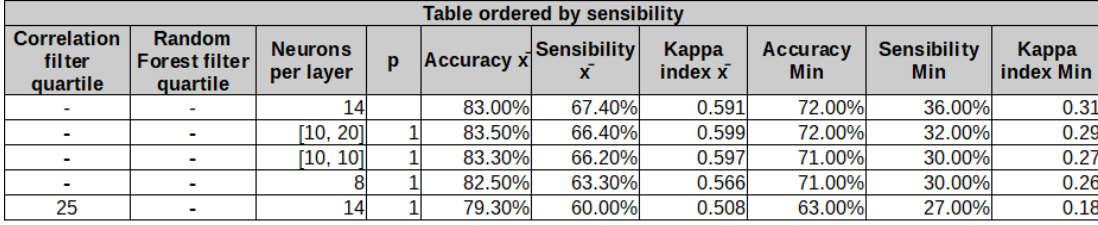
Figure 1. Statistics of the best models applied in the Vigo. A production area, ordered by descending sensibility. Access to the full table can be obtained here: https://github.com/AndresMolares/